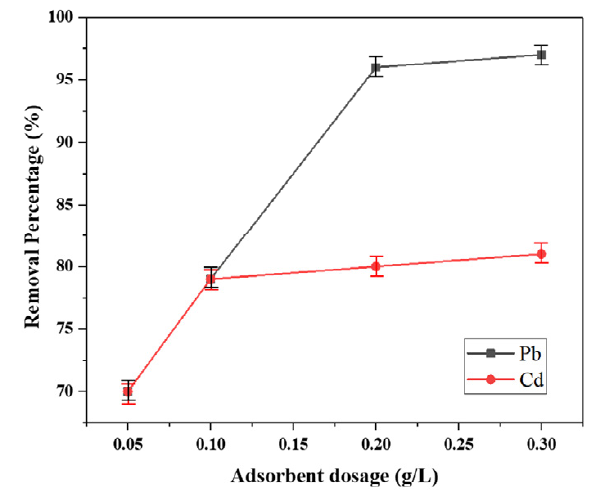
Fig. 9. Effect of adsorbent dosage on the removal percentage (±0.7) of Cd(II) and Pb(II) (pH:5, initial concentration: 50 mg.L -1 , and contact time: 30-40 min).